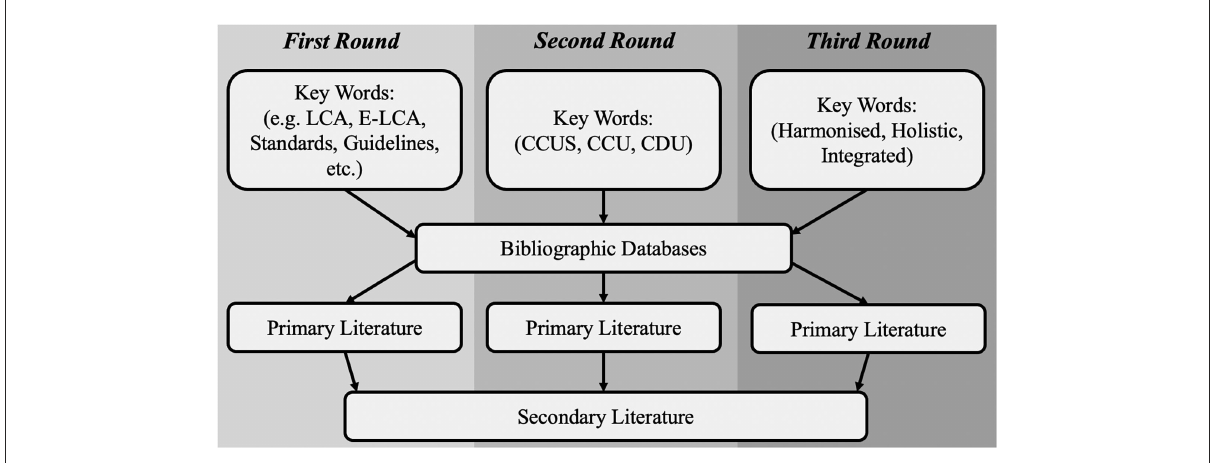
FIGURE1 Schematic of the semi-systematic literature search employed.